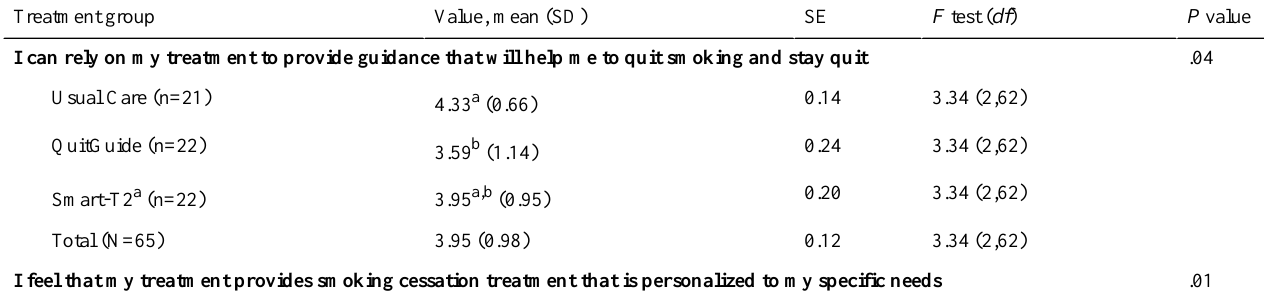
Table 2. Treatment satisfaction and app perceptions at week 4